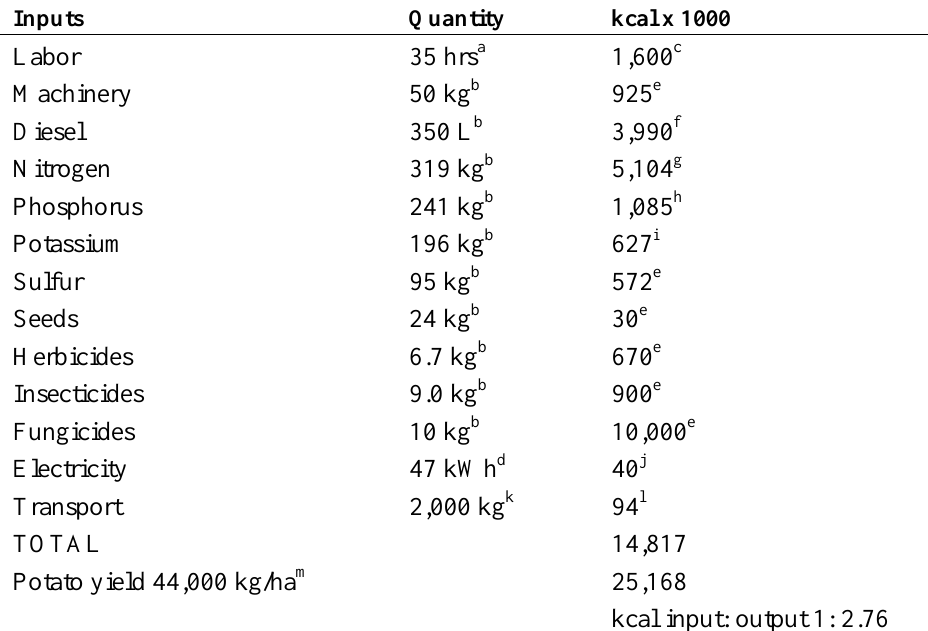
Table 11. Energy inputs in potato production per hectare in the